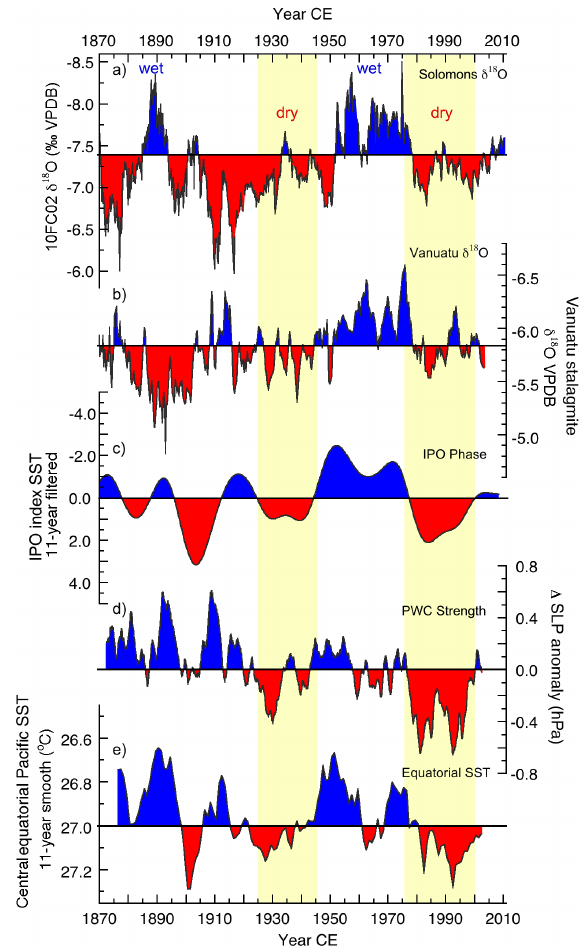
Figure 12. PDV variability as manifest in stalagmite δ 18 O and se- lect ocean and atmospheric records since 1870 CE. (a) Solomons stalagmite δ 18 O, (b) Vanuatu stalagmite δ 18 O, (c) Interdecadal Pa- cific Oscillation index (IPO) of SST anomalies (Folland et al., 2002), (d) sea level pressure (SLP) gradient anomaly as calculated by Vecchi et al. (2006) from the Kaplan SLP data set, taken in the lit- erature as a surface expression of Pacific Walker circulation (PWC) strength, and (e) 11-year running average of annual mean central tropical Pacific SST over 5 ◦ S to 5 ◦ N, 120 ◦ W to 170 ◦ W. Sim- ilar smoothing has been used in previous examinations of decadal SST variability in the central Pacific (e.g. Zhang et al. 2006). Identi- fied phases occurred from 1925 through 1946 (22yr duration), 1947 through 1976 (30yr duration), and 1977 through 1998 (22yr dura- tion). There is better agreement between the proxy records and the climate records in the more recent times than in earlier times. This lack of agreement might be caused by decreases in the signal-to- noise ratio in the earliest portion of the instrumental records (e.g., Giese and Ray, 2011; L’Heureux et al., 2013) and age model un- certainties in the stalagmite records. This suggests that rainfall, sea level pressure, and SST change in step on multidecadal timescales, and are also associated with basin-wide reorganizations associated with